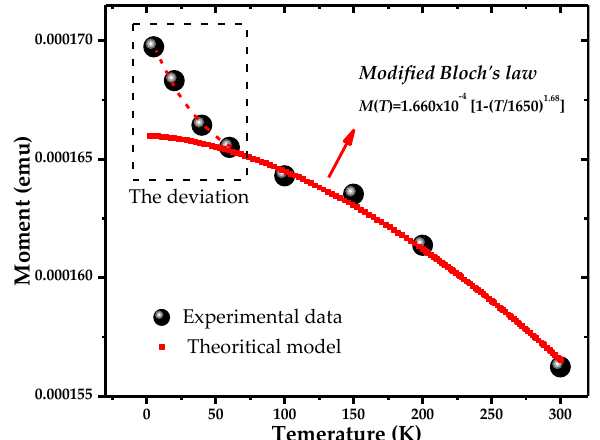
Figure 6. Saturation magnetization as a function of temperature with the red curve representing the modified Bloch’s law.